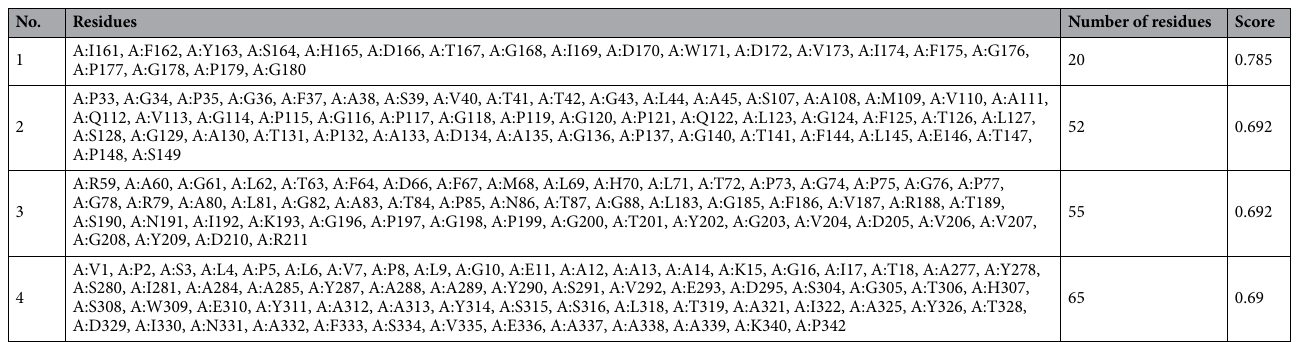
Table 4. ElliPro predicted the conformational B cell epitopes residues of the designed multi-epitope based vaccine.